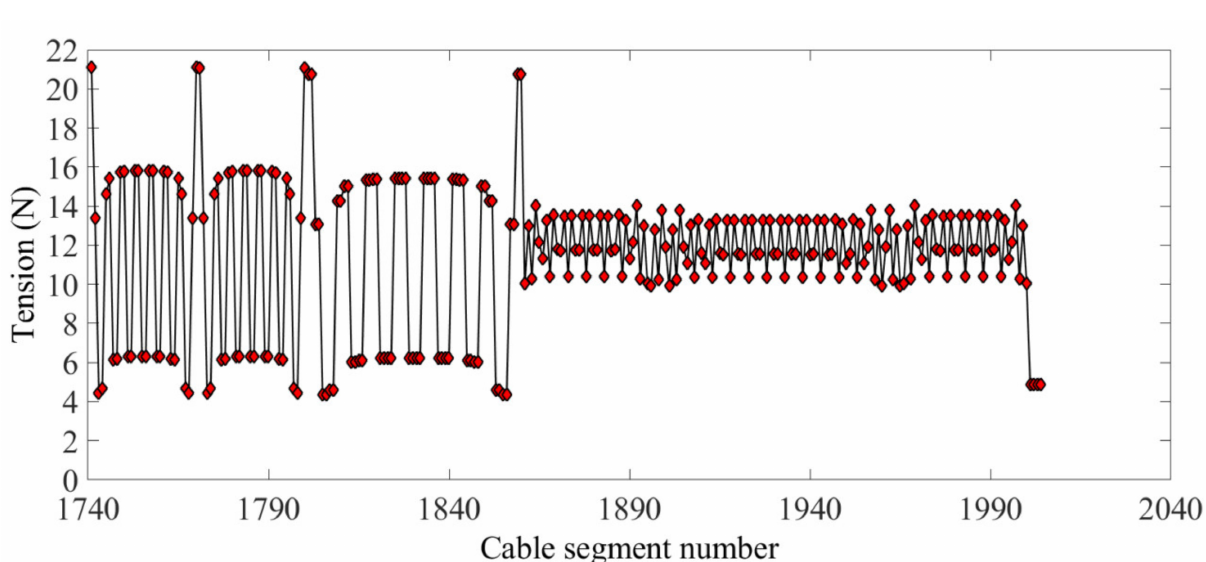
Figure 14. The boundary cable segment